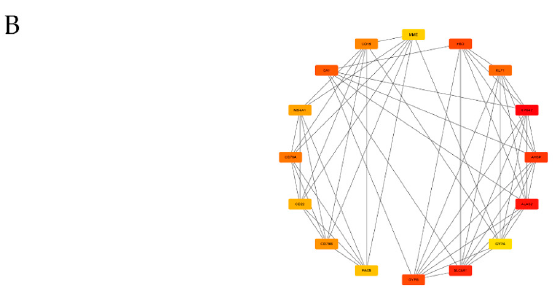
Figure 4. ( A ) PPI network showing interactions between 139 genes for which we found DEGs between children before and after HSCT. ( B ) Hub genes identified from the PPI interaction network with the MCC algorithm. The network consists of 16 node genes. Each line represents an interaction between two genes. The color shift from red to yellow corresponds to decreasing MCC score